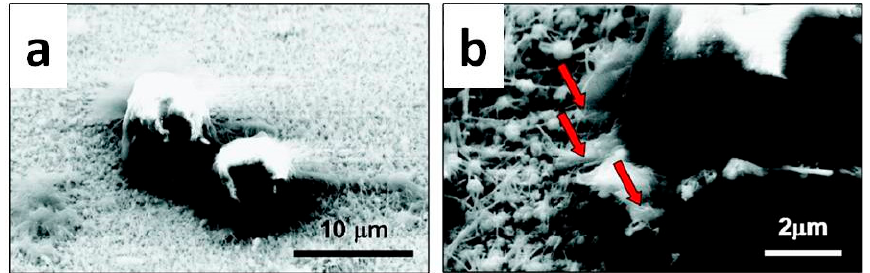
Figure 2. Scanning electron microscopy (SEM) images of HeLa cells on ZnO nanowire (NW) arrays. ( a ) Two HeLa cells grown on the surface of ZnO NW arrays; ( b ) Cells are upheld by the nanowires (NWs). Some ZnO NWs are phagocytosed into the HeLa cell (pointed out by the red arrow). The diameter and the length of the nanowires are ~100 nm and ~1.5 μ m, respectively. Adapted with permission from reference [87]. Copyright (2008) American Chemical Society.